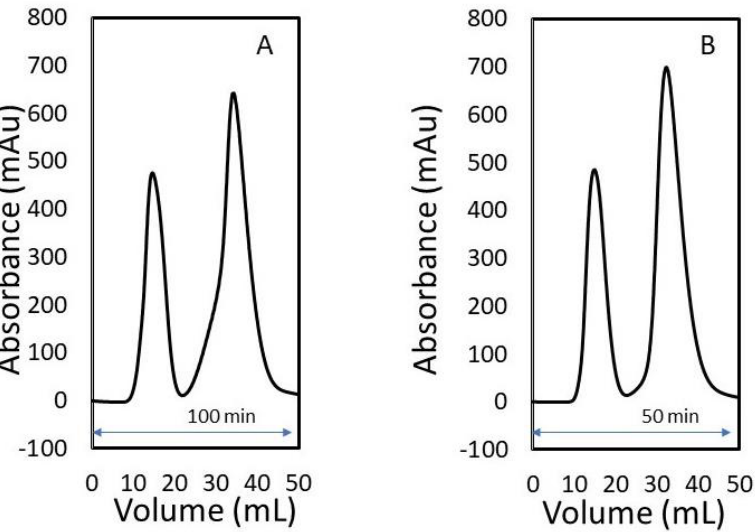
Figure 7. Chromatograms obtained during BSA (5 mg/mL) and lysozyme (2.5 mg/mL) separation using ( A ) the 24 mL Tricorn GL 10/300 column at a 0.5 mL/min flow rate and ( B ) the 24 mL z 2 cuboid SEC device at a 1 mL/min flow rate (medium: Sephacryl S-200 HR; mobile phase: phosphate-buffered saline (pH 7.4); loop size: 5